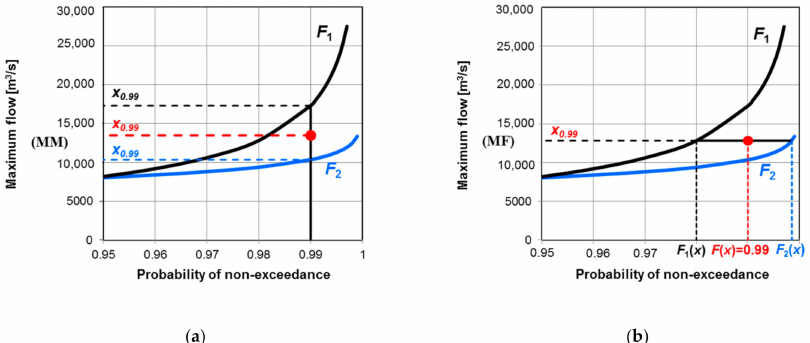
Figure 3. Two schemes of aggregating distributions: ( a ) aggregation of quantiles (MM—mean magnitude); ( b ) aggregation of probabilities of non-exceedance (MF—mean